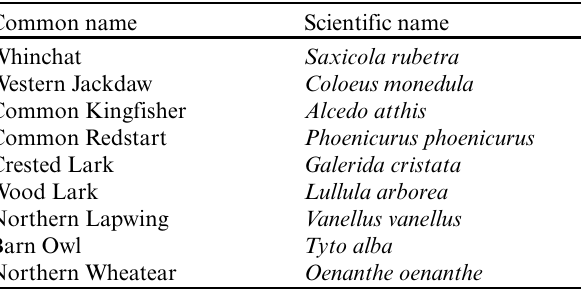
Table 1. Red List bird species considered in the biodiversity